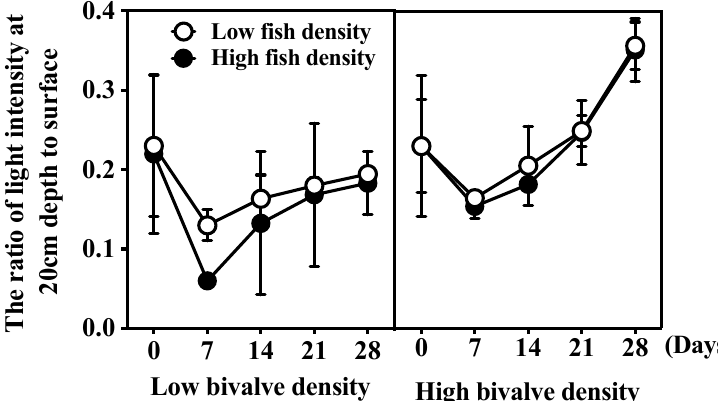
Figure 5. Variations in the ratio of light intensity at 20 cm water depth relative to the water surface in the di ff erent treatments during the experiment (means ± SD).